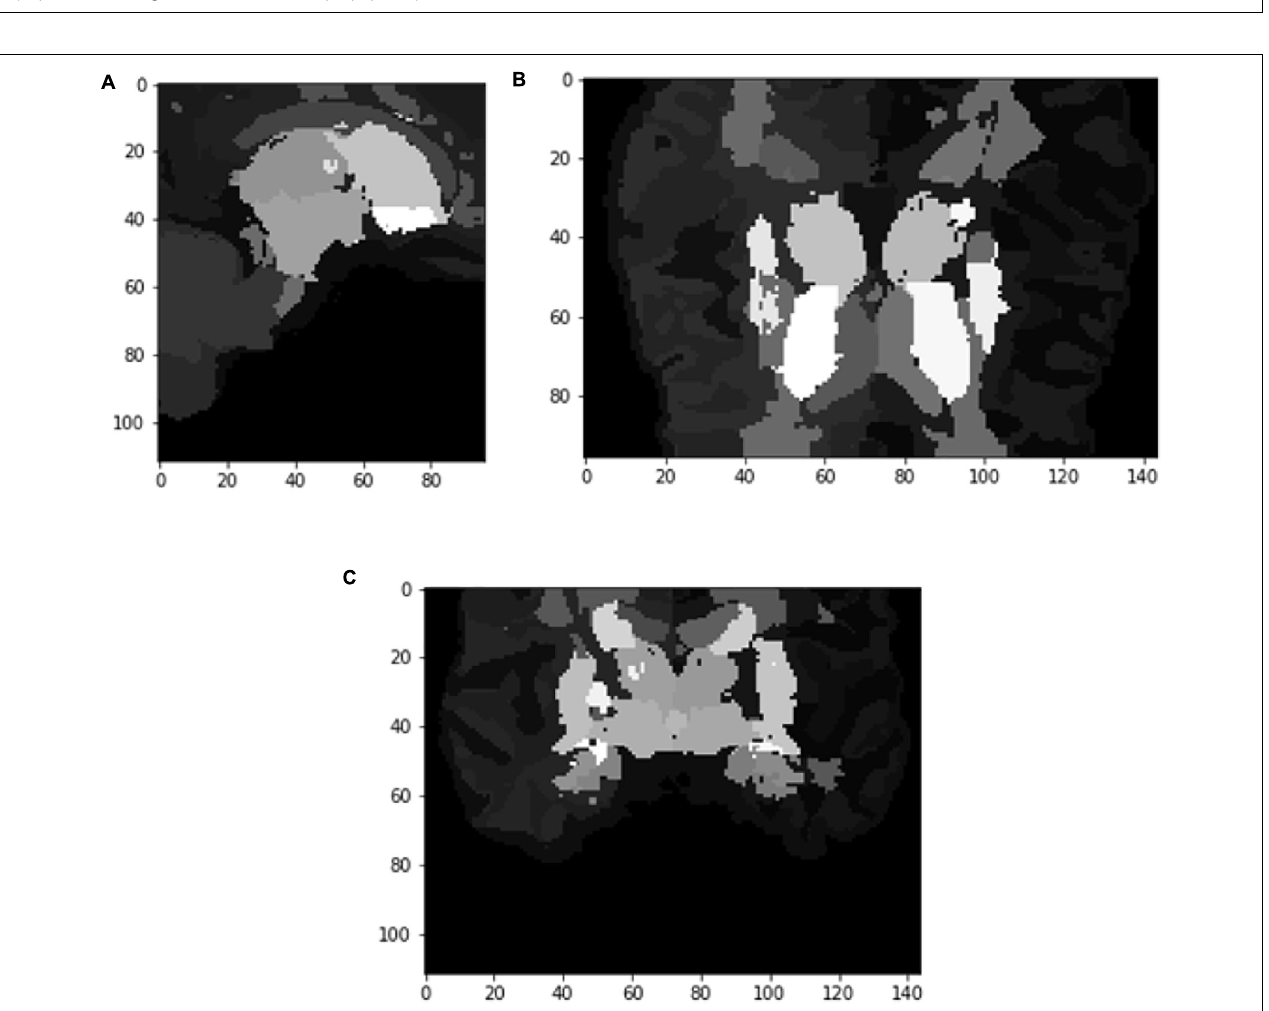
FIGURE 6 | Slices (A) Sagittal, (B) coronal, and (C) axial planes. The output of VoxelMorph of session OAS30319_MR_d0043. Each brain structure has a unique label with grayscale values varying from 0 to 40. Later with filtering, each region is separated, and the Box-Counting FD is calculated. The images are shown using NiBabel library version 3.2.1 (https://zenodo.org/record/4295521#.YCpJqeqxWMI).